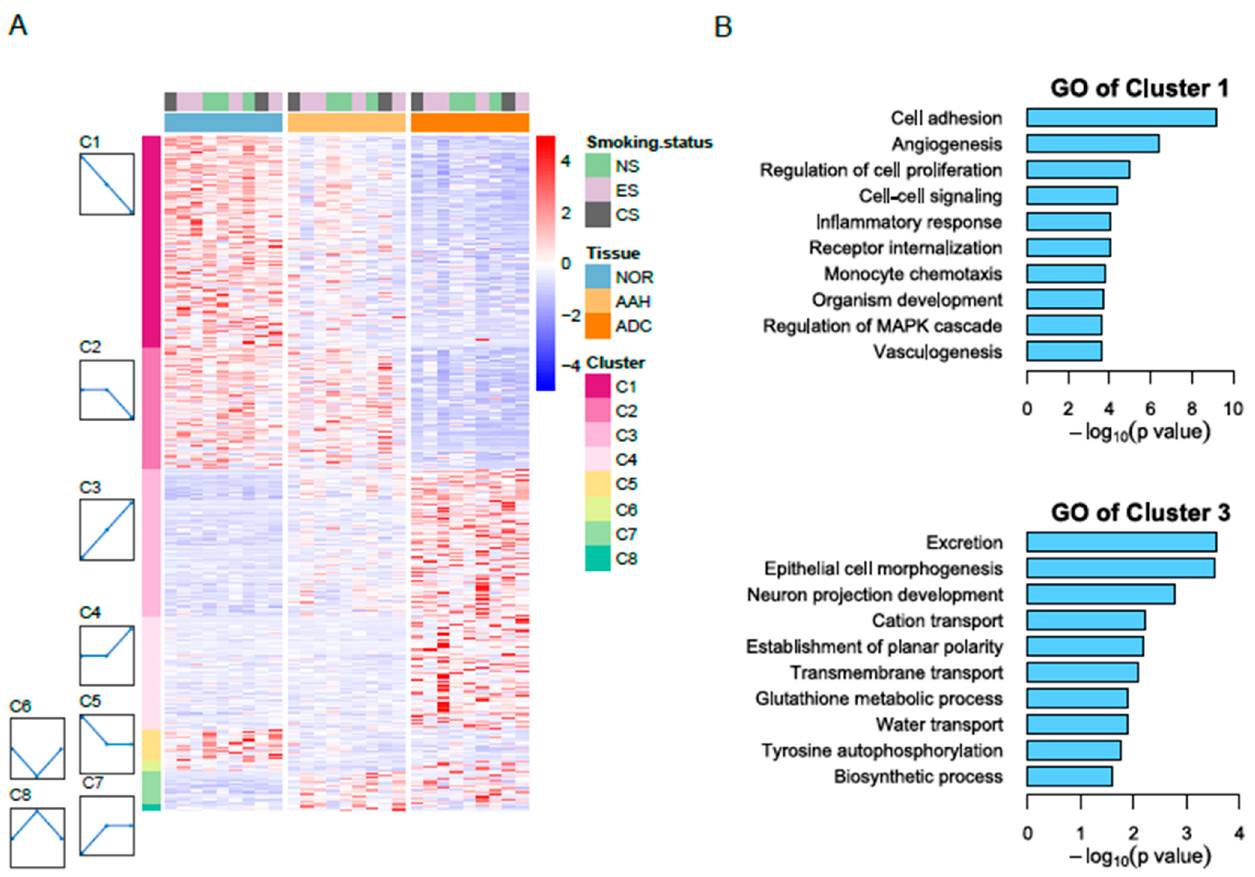
Figure 1. RNA-seq reveals differentially expressed genes in three tissue types. ( A ) Heatmap of differentially expressed genes in normal, AAH, and ADC tissues. Differentially expressed genes (DEGs) were grouped into eight clusters based on distinct gene expression profiles, namely C1 to C8. ( B ) Gene Ontology (GO) biological process results for Cluster 1 with decreasing pattern from normal to ADC ( top ) and for Cluster 3 with increasing pattern ( bottom ). AAH, atypical adenomatous hyperplasia; ADC, adenocarcinoma; CS, current smokers; ES, ex-smokers; NS, non-smokers.